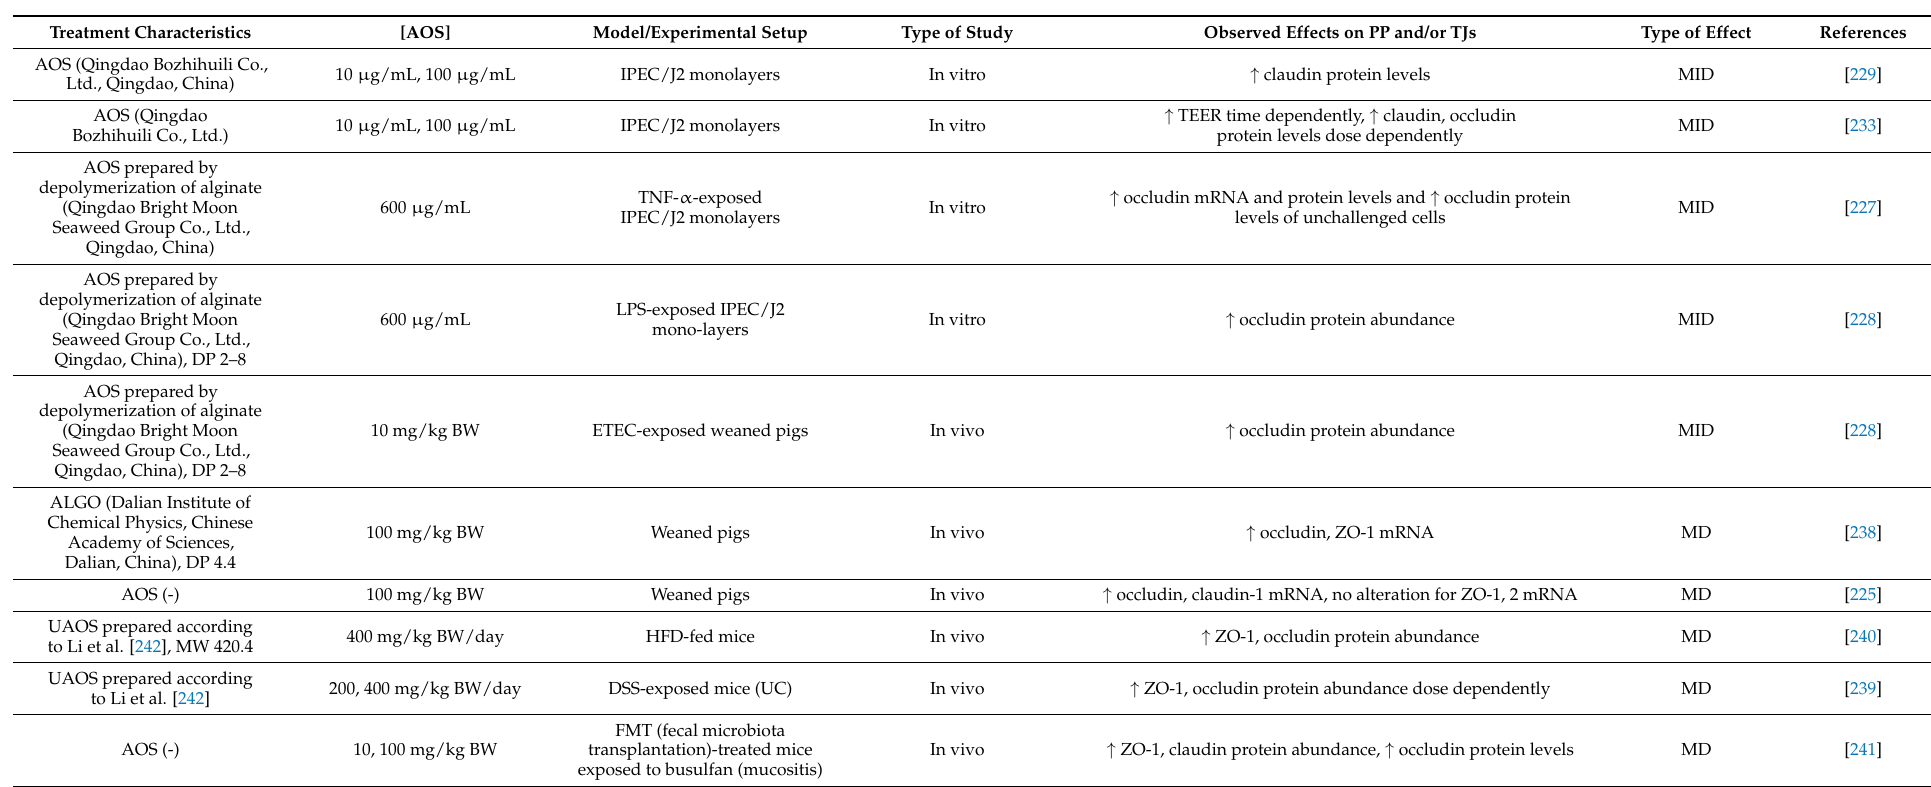
Table 3. Microbiota-dependent and independent effects of AOS on paracellular permeability and/or